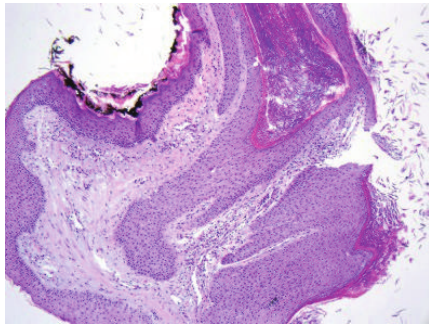
Figure 2: Initial biopsy showing acanthosis, hyperkeratosis, and keratotic plugging (HE, 10x).